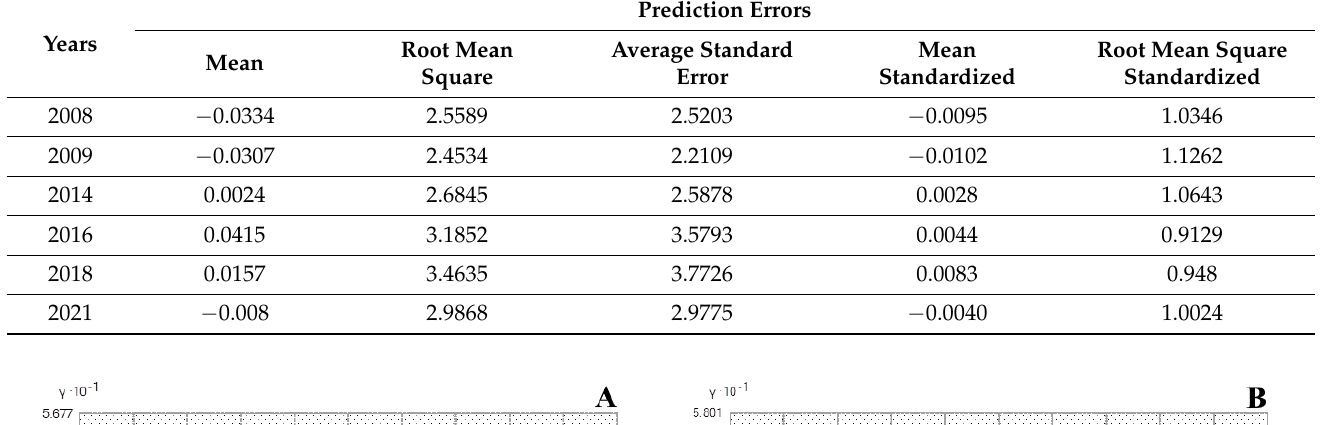
Table 5. Prediction errors of the selected models.